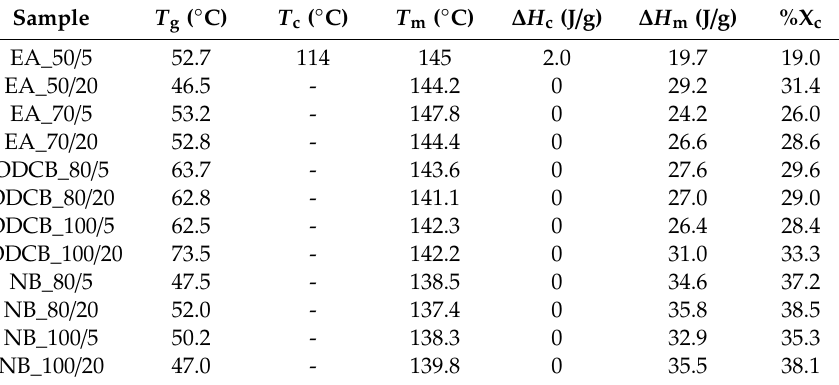
Table 4. DSC data of solvent treated